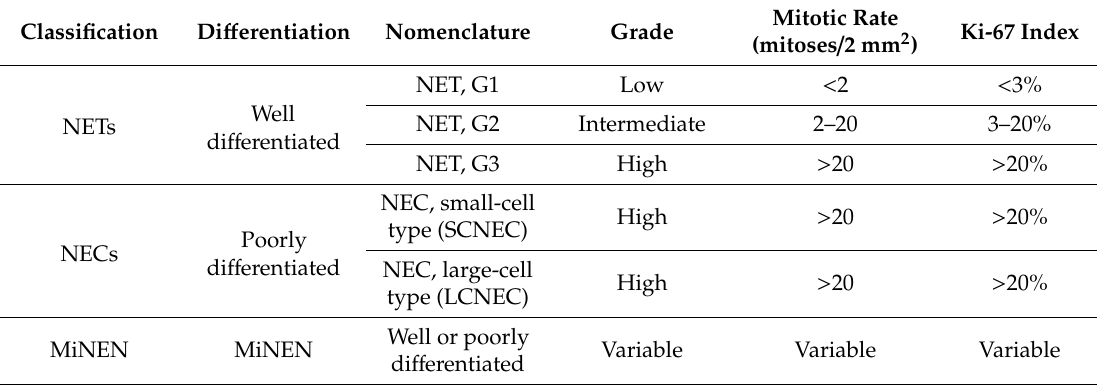
Table 1. Classification and grading criteria for GEP-NENs, according to the WHO 2019 Grading